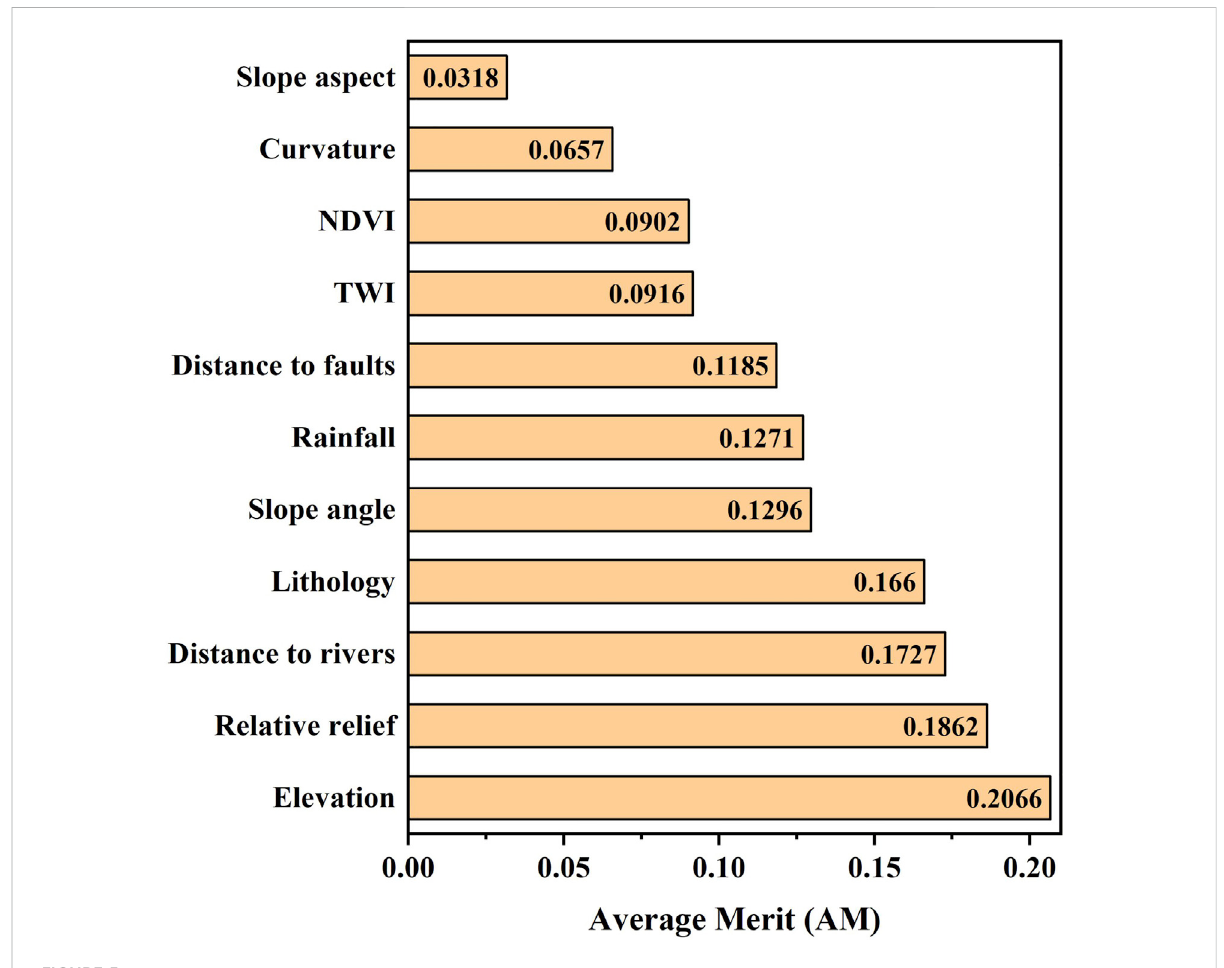
FIGURE 5 Predictive capabilities of LCFs using the CAE